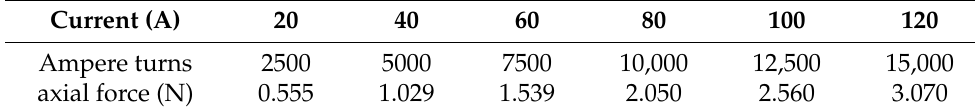
Table 2. Electromagnetic force and current characteristic table.